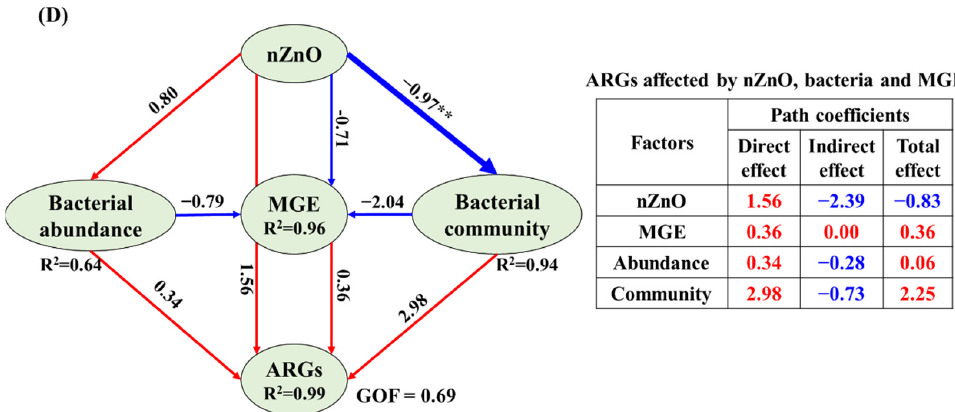
Figure 4. The partial least squares path model (PLS-PM) shows different factors ′ direct and indirect effects on ARGs abundance in sediment. ( A ) sediment added with nZVI but without tetracycline, ( B ) sediment added with nZnO but without tetracycline, ( C ) sediment added with nZVI and overlaid with 10 mg L − 1 tetracycline, and ( D ) sediment added with nZnO and overlaid with 10 mg L − 1 tetracycline. Red indicates a positive effect, while blue represents a negative effect. *, **, and *** represent p < 0.05, p < 0.01 and p < 0.001, respectively. Abundance indicates bacterial abundance, and community represents bacterial community.